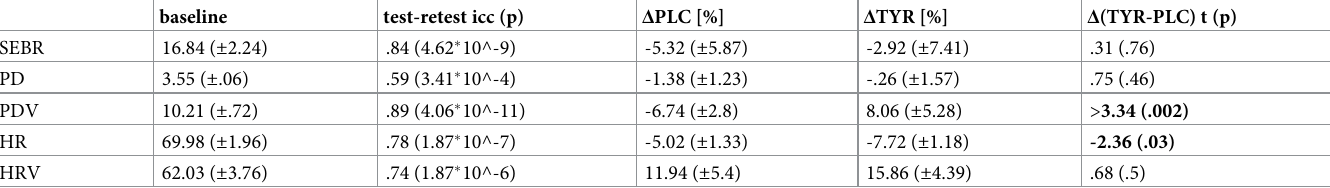
Table 1. Mean (standard error) of physiological arousal markers during the two baseline sessions, test-retest reliability (intraclass correlation coefficient, p-value), and related percent change thereof 1h post placebo / tyrosine (PLC / TYR) intake. The last column depicts paired t-tests computed on changes following tyrosine vs. placebo. SEBR: spontaneous eye blink rate per minute; PD: mean pupil dilation size; PDV: pupil dilation variability (standard deviation/mean � 100); HR: heart rate; HRV: heart rate variability–standard deviation of normal-to-normal heart beat intervals. Sample size: N = 28 (per measurement